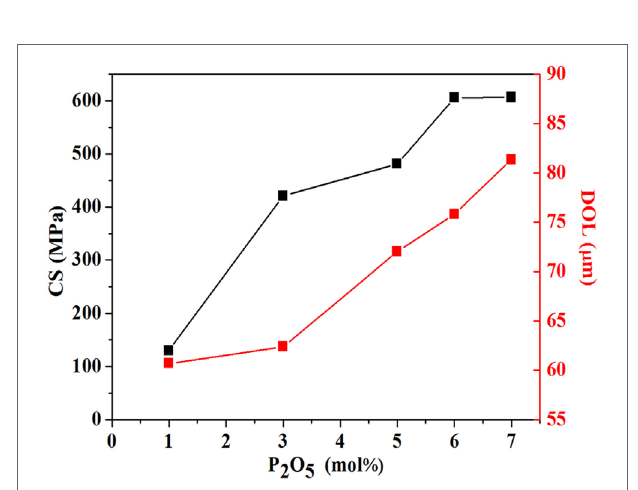
FigUre 4 | Vickers hardness values of x P 2 O 5 –(100 − x )(0.25na 2 O– 0.08al 2 O 3 –0.67siO 2 ) ( x = 1, 3, 5, 6, and 7 mol%, respectively) glass series treated at 400°c for 6 h . (a) Vickers hardness as a function of the concentration of P 2 O 5 at room temperature before and after ion-exchange treatment; (B) images of the indentations of ion-exchanged glasses after a load of 0.98 N for 10 s.